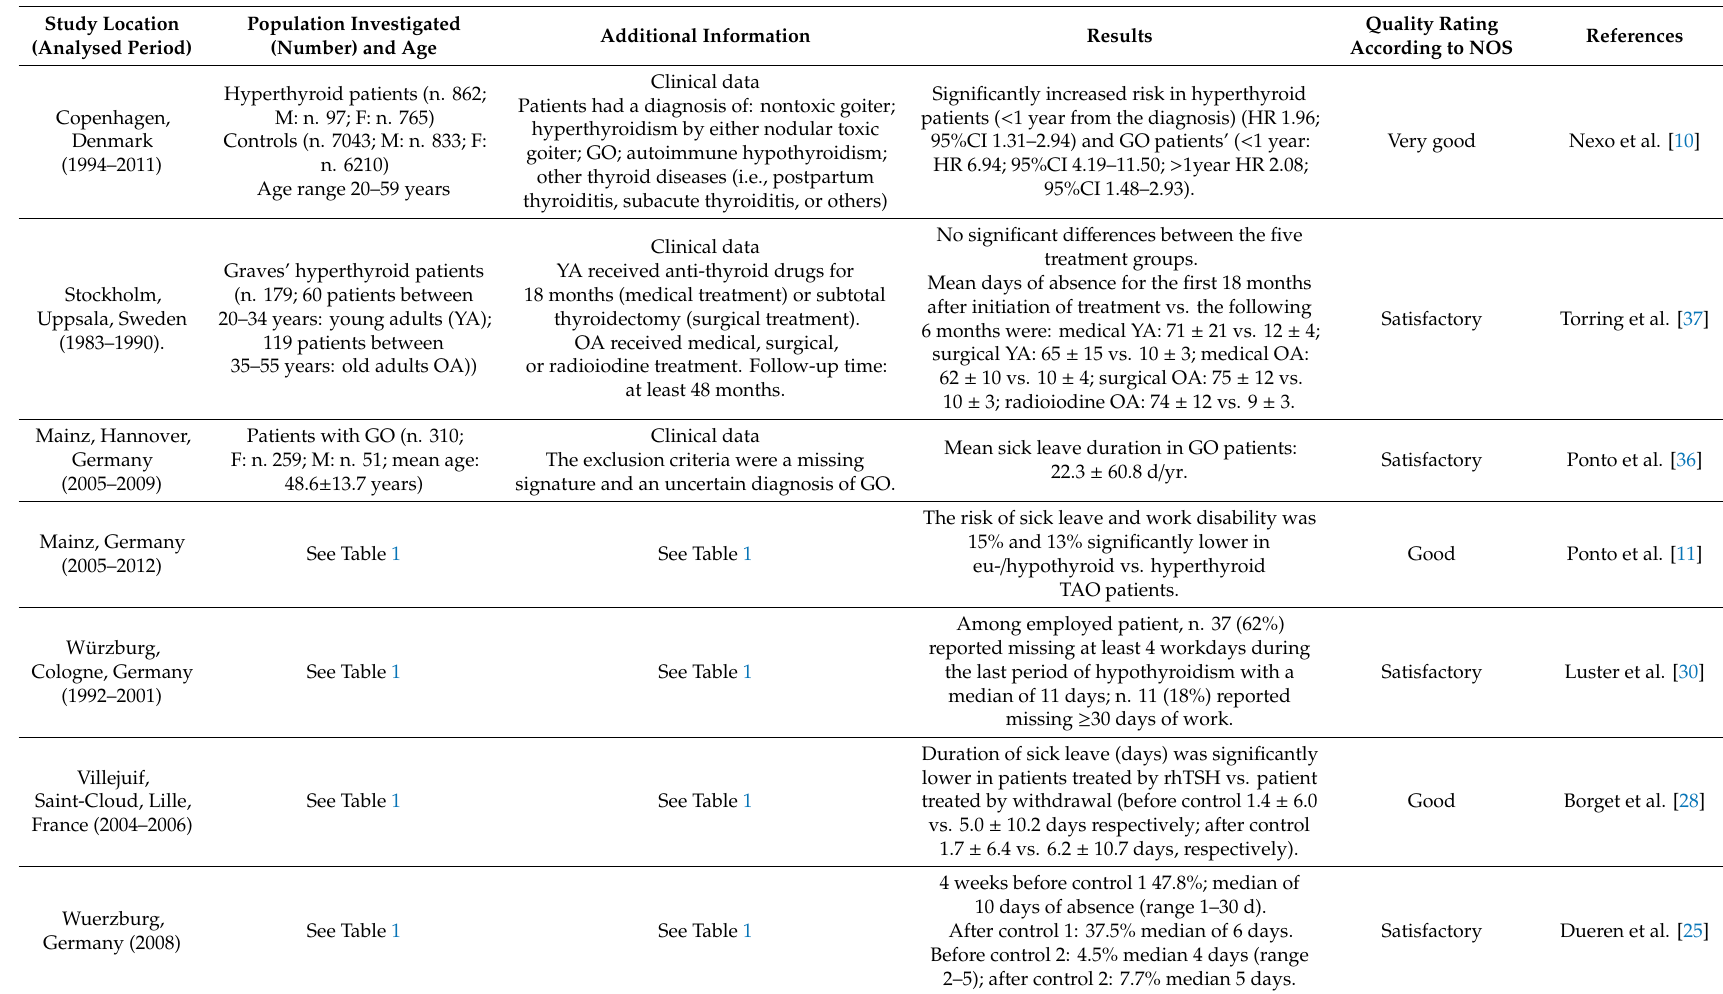
Table 2. Summary of the studies addressing the impact of thyroid disease on sick leave.